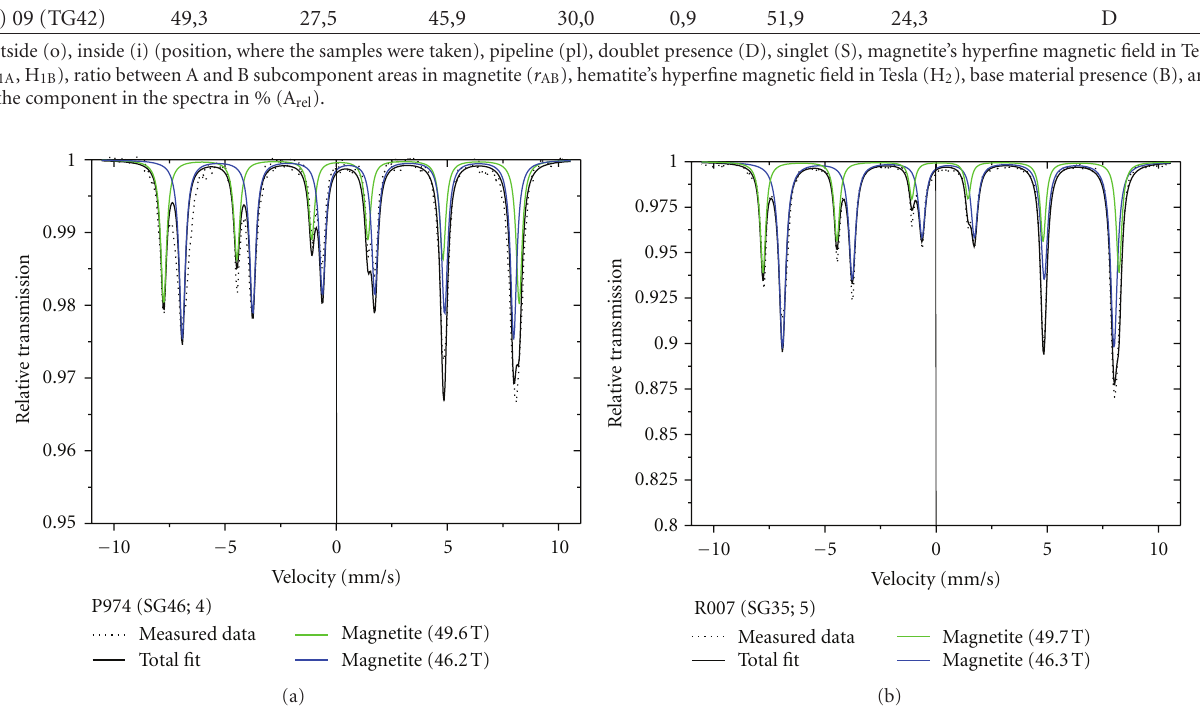
Figure 4: M¨ossbauer spectra of SG46 and SG35 samples. Both samples contain only magnetite